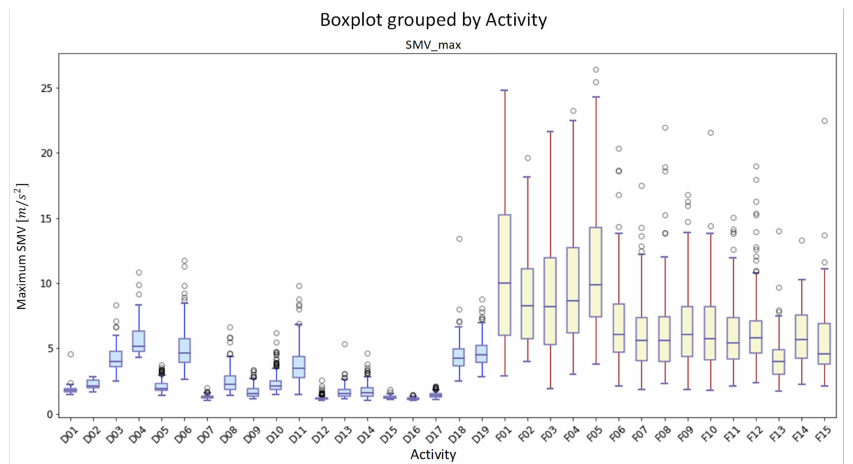
Figure 5. The boxplot of maximum of signal magnitude vector ( SMV max ) of the acceleration. The rectangle represents the distribution range of data and the discrete points represent a few abnormal